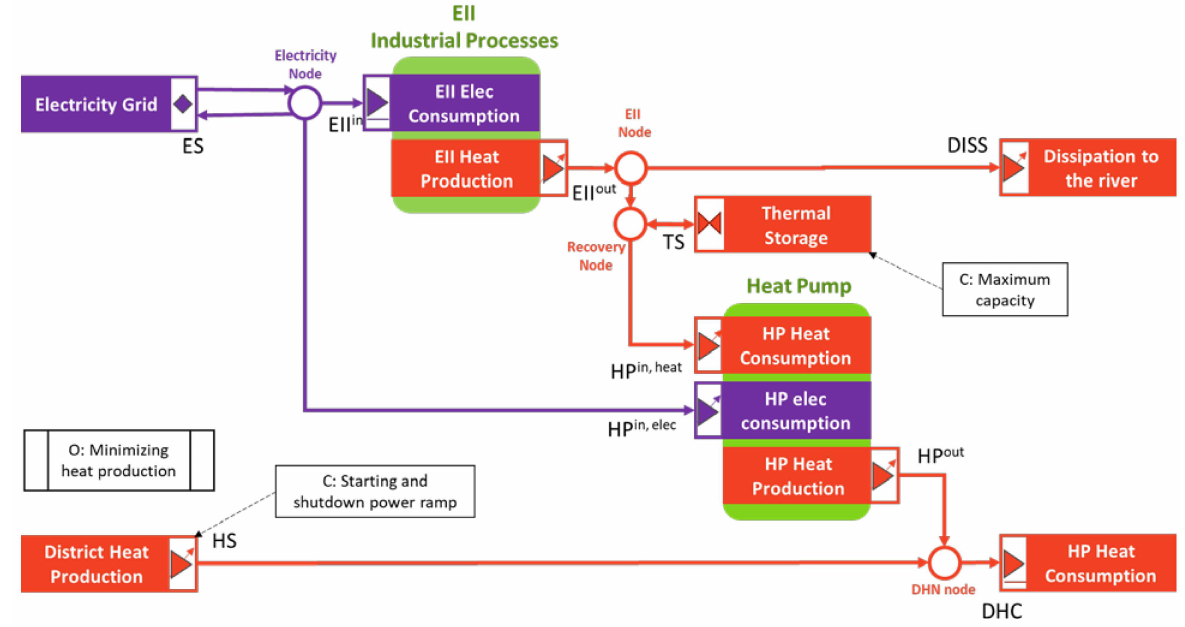
Figure 7. OMEGAlpes graphical representation of the waste heat recovery use case, including the main constraints and